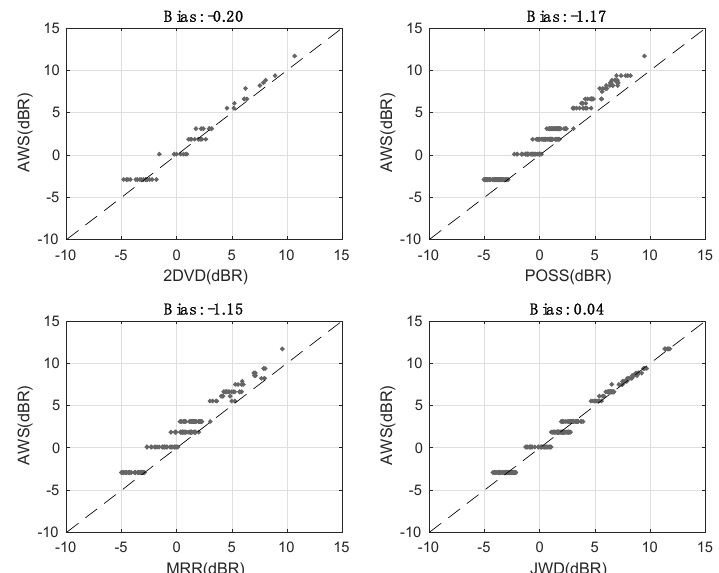
Figure 3. The hourly mean rainfall rate (dBR) from four types of disdrometer and the tipping bucket rain gauge (AWS) of the Central Weather Bureau of Taiwan (Gongguan station: N 0 25.0164, E 0 121.5311). The mean bias values compared to AWS for each disdrometer are − 0.20 dB (2DVD), − 1.17 dB (POSS), − 1.15 dB (MRR) and 0.04 dB (JWD).